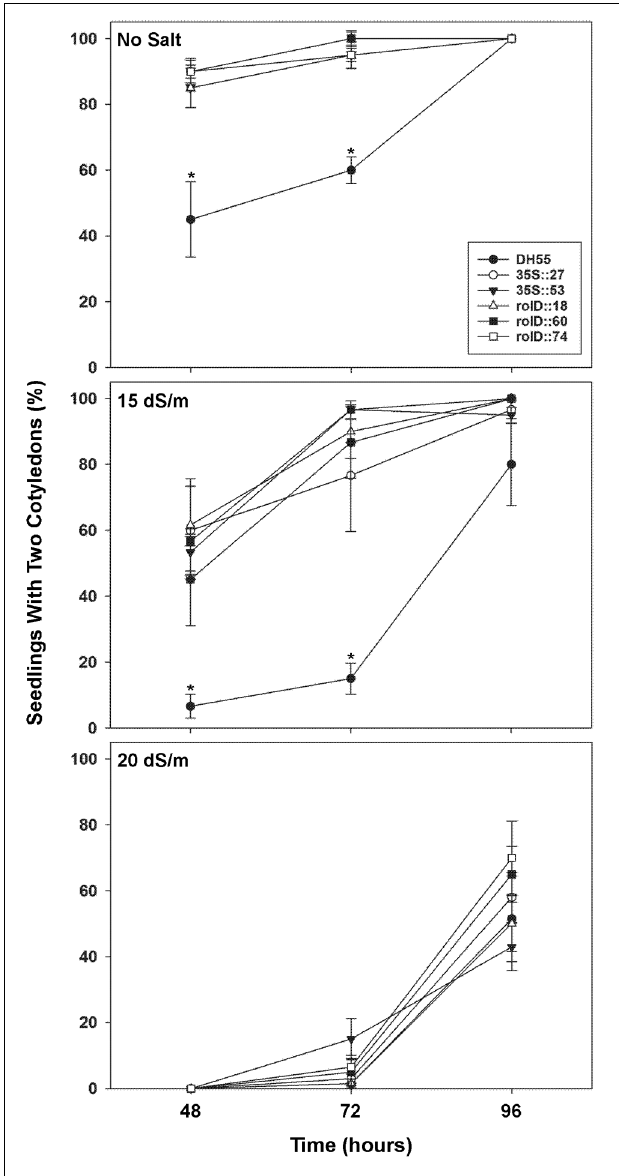
FIGURE 4 | The effect of acdS expression on the rate of germination of camelina seeds in the absence, or presence of, salt (15 and 20 dSm − 1 ). Lines tested include wild-type C. sativa DH55 or independent, single insert, homozygous transgenic lines expressing the acdS gene under the control of the root-specific rolD promoter or the constitutive CaMV 35S promoter. Error bars indicate standard error [ n = 60 seeds divided in three plates (20 seeds/ plate)]. A two- way ANOVA and Tukey post-test were used to detect significant differences between groups. Asterisks ( ∗ ) indicate control (DH55) values that are significantly different ( p < 0.05) from the transgenic